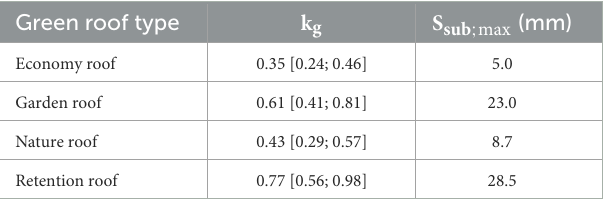
TABLE 2 Summary statistics of optimized green roof factors k g across all Rolling Forward Forecast (RFF) iterations for the four green roof types. Green roof